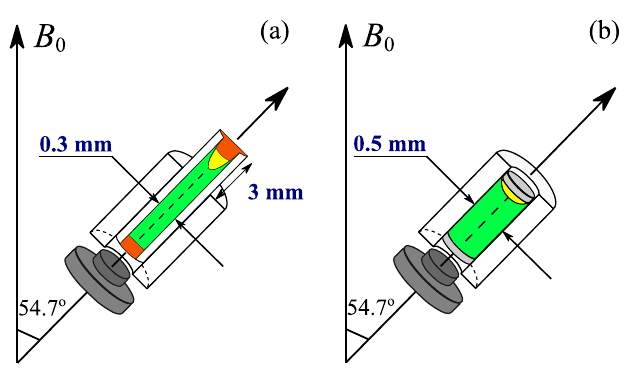
Figure 1. Illustration of the new capillary-inserted rotor ( a ) and the previous Kel-F rotor ( b ) designs. In ( a ), the sample (green) is contained in the glass capillary where the two ends are sealed by wax (orange). The sealed capillary is located inside the Kel-F rotor. In ( b ), the sample (green) is directly injected into the rotor and then enclosed by the two Kel-F inserts (light grey). The small gaps (yellow) between the wax ( a ) or the Kel-F insert ( b ) and the sample of the two models refer to air bubbles, which are outside or inside of the detection region, respectively. The extension length (3 mm) of capillary in ( a ) is used for better visualization, so it is not correctly scaled.